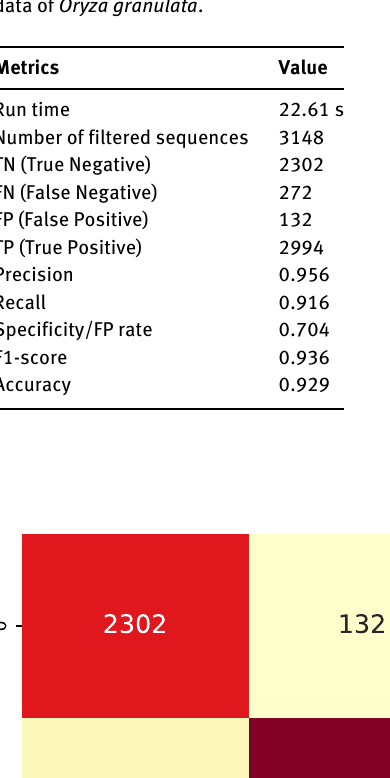
Figure 12: Confusion matrix performed with the gener- alization test dataset for the LTR_STRUC datasets of O. granulata